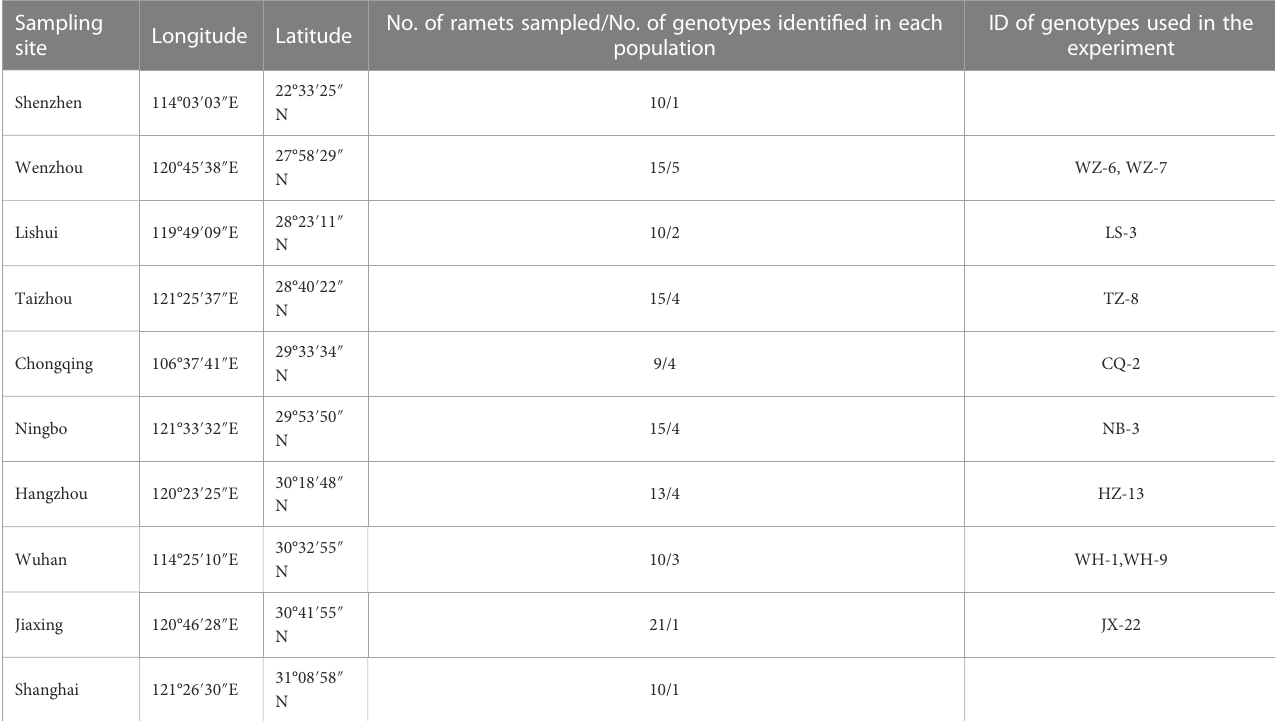
TABLE 1 Sampling cites of the initial ramets of H. vulgaris for genotype identi fi cation. Sampling